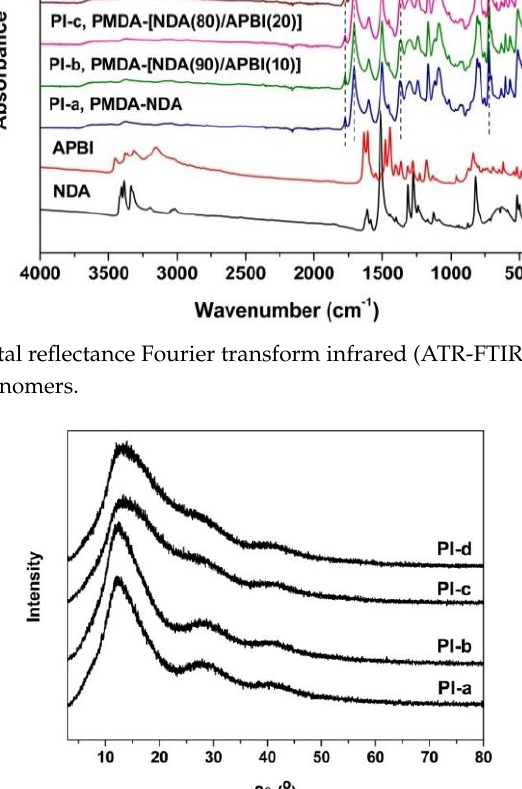
Figure 3. Attenuated total reflectance Fourier transform infrared (ATR-FTIR) spectra of PI films and the starting diamine monomers.